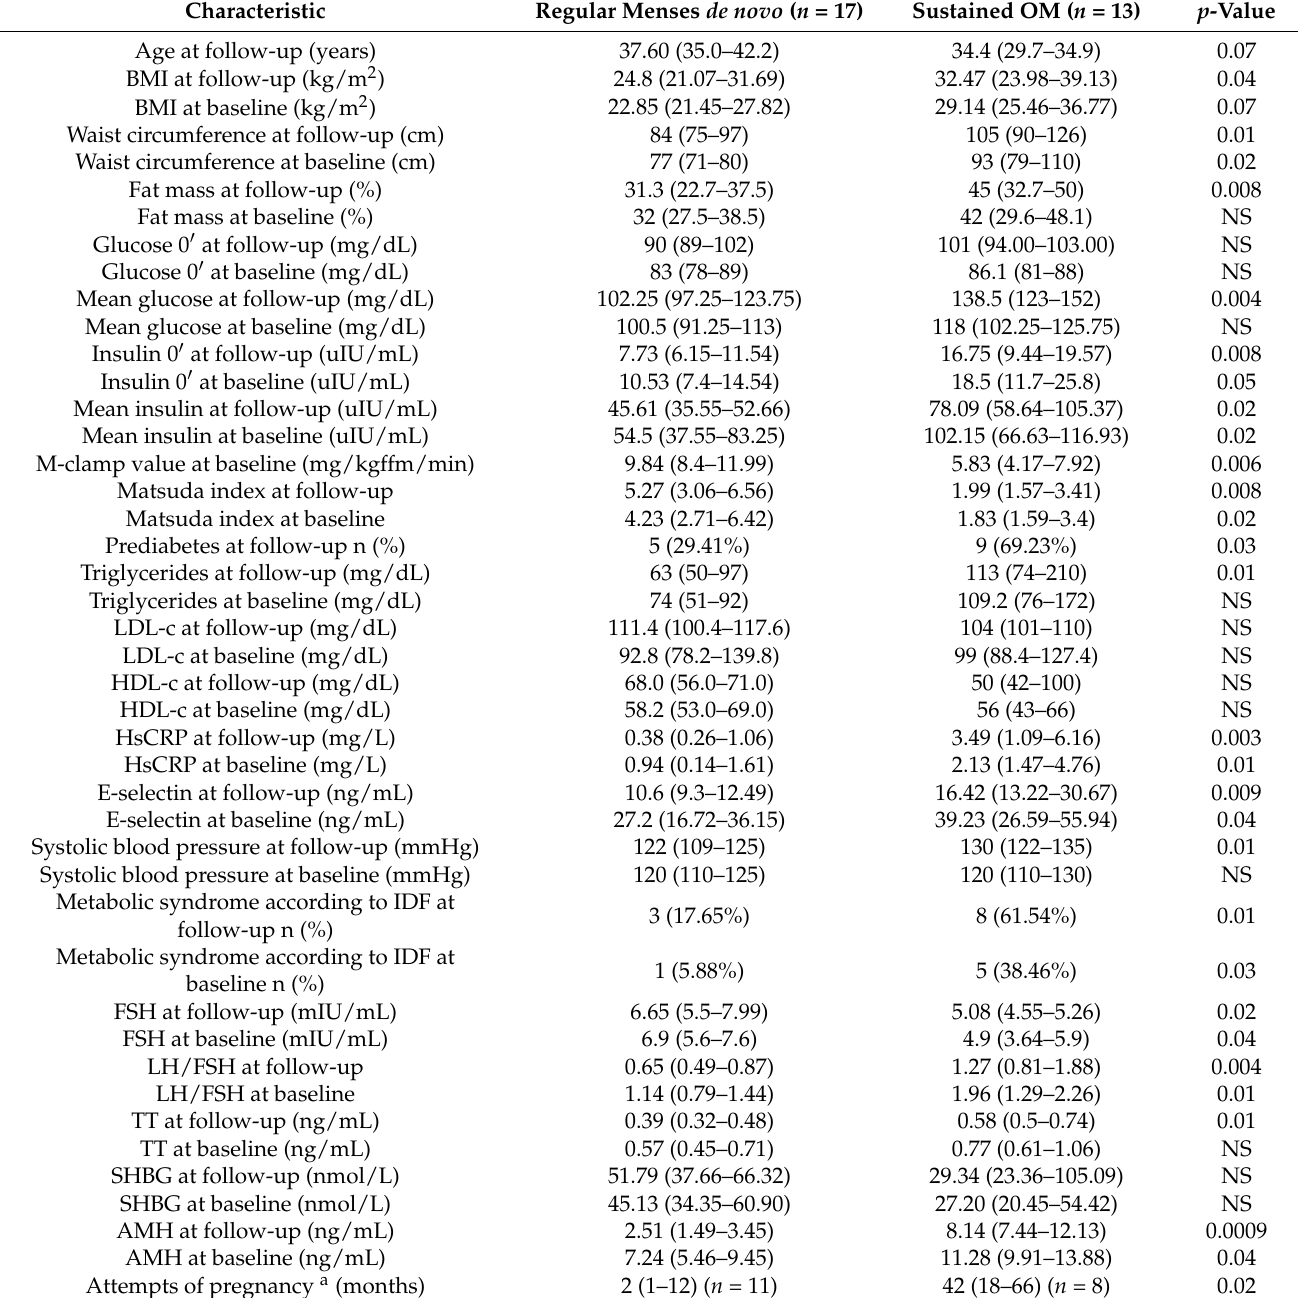
Table 3. Characteristics of the women according to menstrual pattern assessed at the end of the follow-up.